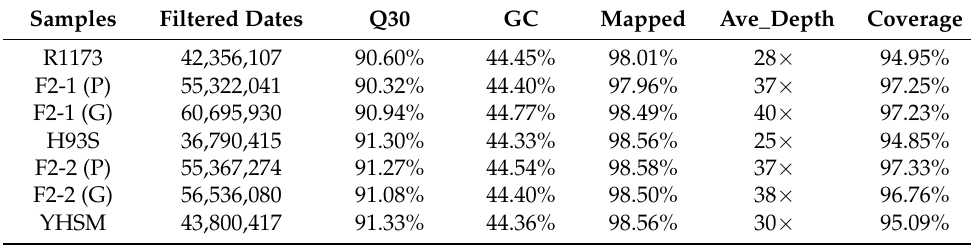
Table 2. The data quantity and quality in BAS-seq.